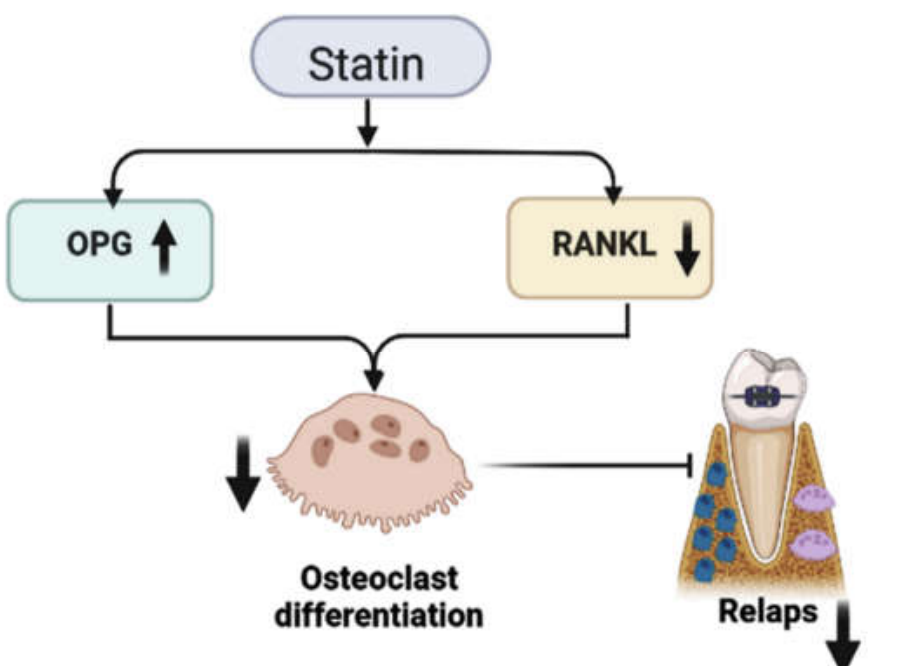
Figure 3. Statin’s method of action for preventing orthodontic relapse. Table 1. The effect of statins in animal models of orthodontic relapse.